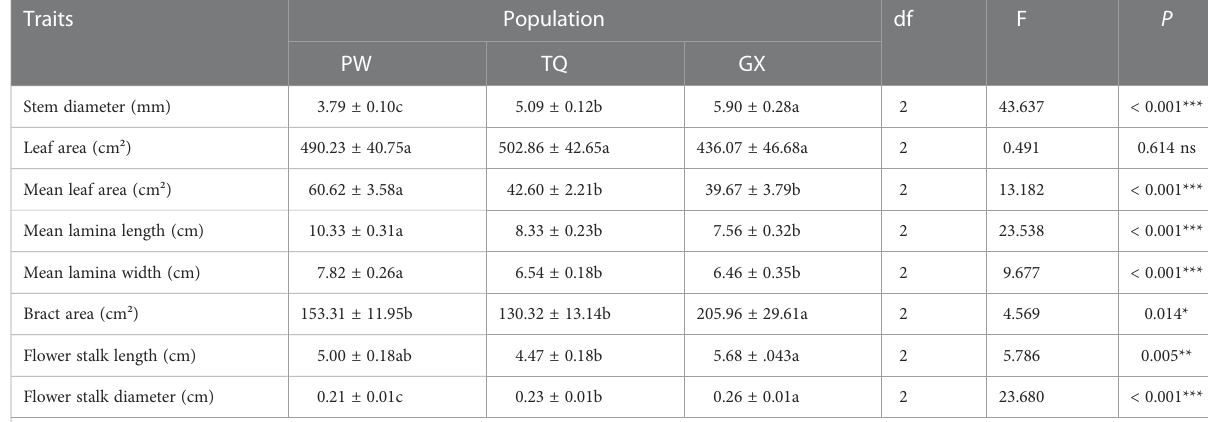
TABLE 2 The morphological traits of annul D . involucrata twig in three latitude regions (mean ± SE ).